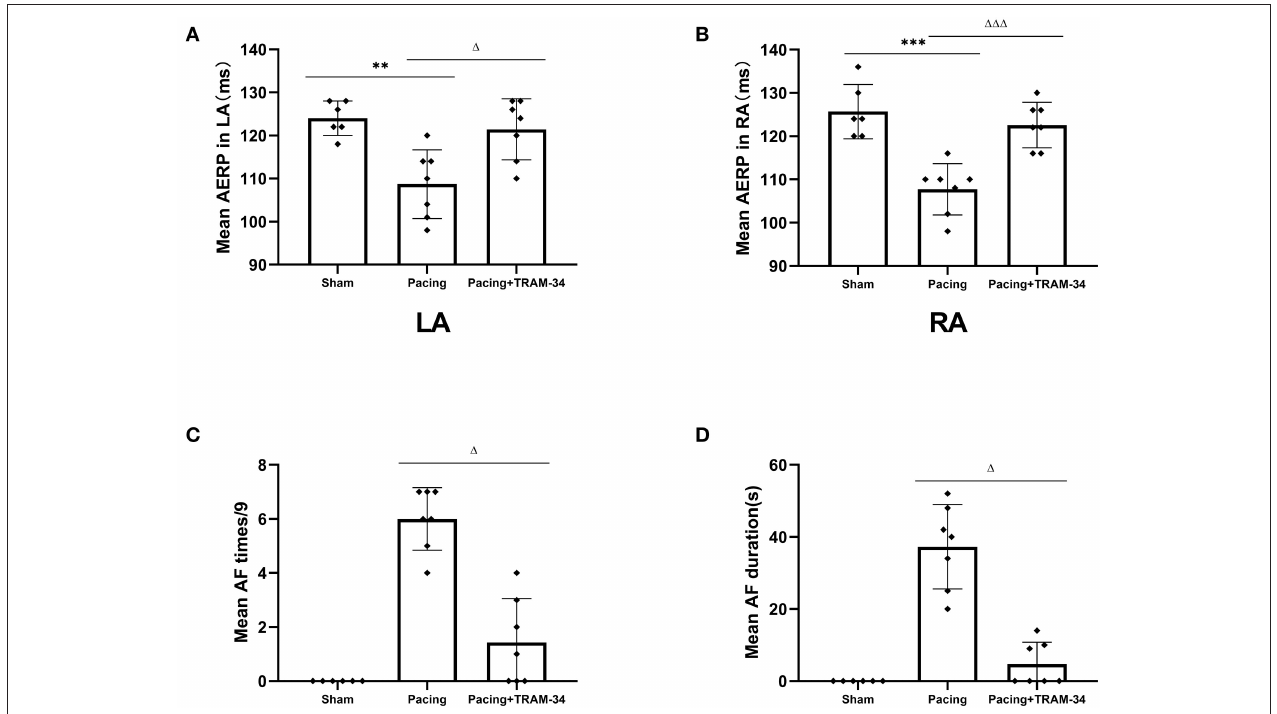
FIGURE 1 | Mean AF inducibility, AF duration and AERP in all groups. (A,B) The mean AERP in both LA and RA was substantially greater in the pacing group than in the other two groups, and the pacing + TRAM-34 group was substantially greater than in the sham group. (C) The mean AF incidence rate was substantially greater in the pacing group than in the other two groups, and for the pacing + TRAM-34 group it was substantially greater than in the sham groups. (D) The mean AF duration was substantially greater in the pacing group than that in the other two groups, and in the pacing + TRAM-34 group it was substantially greater than in the sham group. P ** < 0.01 vs. the sham group, P *** < 0.001 vs. the sham group. P 11 < 0.01 vs. the pacing group, P 111 < 0.001 vs. the pacing group. AF, atrial fibrillation; AERP, atrial effective refractory period; RA, right atrium; LA, left atrium.